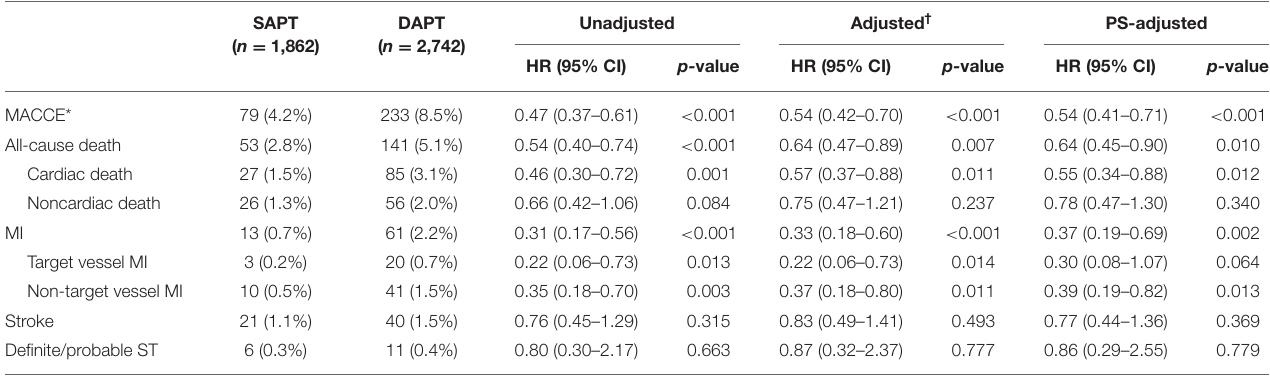
TABLE 3 | Comparison of clinical outcomes.